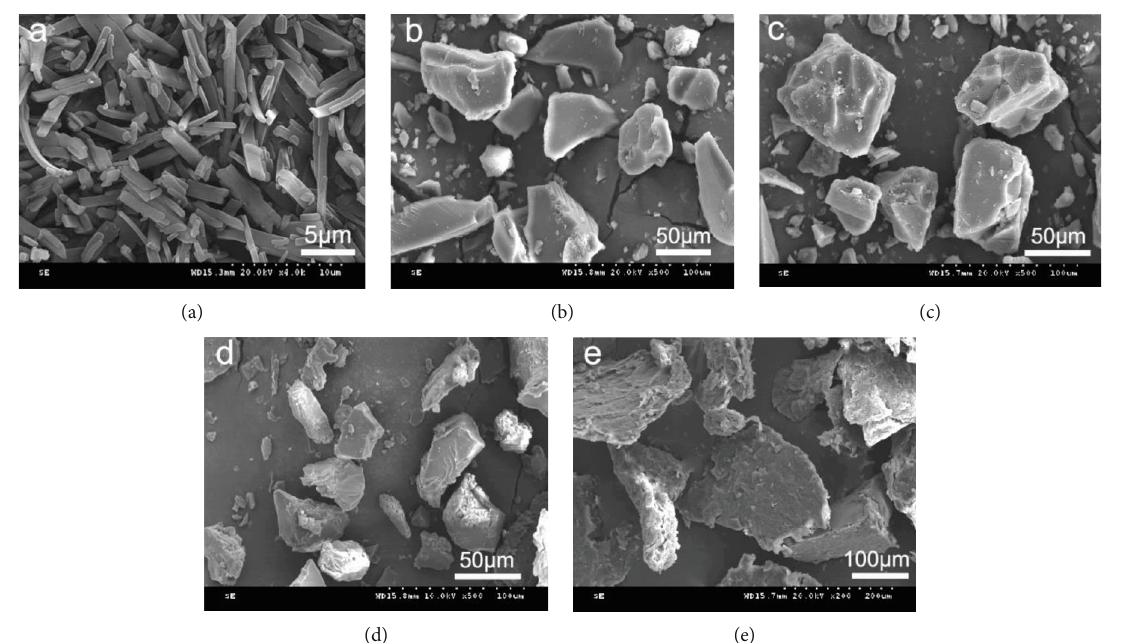
Figure 8: SEM images of (a) pure GA and SDs prepared using (b) PVP K15, (c) PVP K17, (d) PVP K30, and (e) PVP